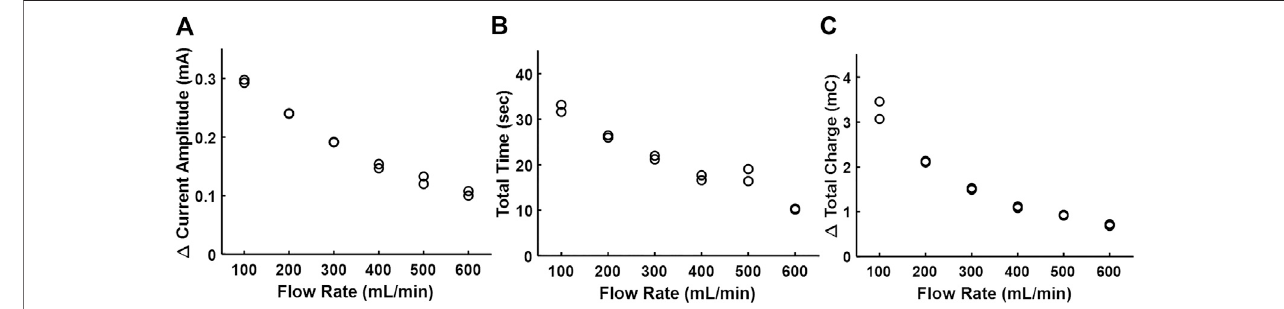
FIGURE 4 | Effect of the increasing fl ow rate of water on the electrodilution metrics. (A) Δ Current amplitude, (B) total time, and (C) Δ total charge. Two saline injections were administered for each fl ow rate (note two data points per fl ow rate). AC voltammetry settings were 0.1 V pk and 0.5 kHz.